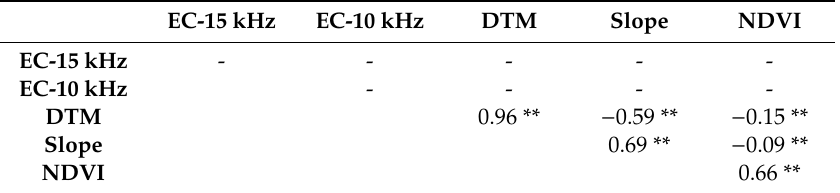
Table 5. Moran Index among the variables used to delineate SSMZ, estimated (using GeoDa software, by Luc Anselin) considering the grid nodes with not valid EMI measurements (area